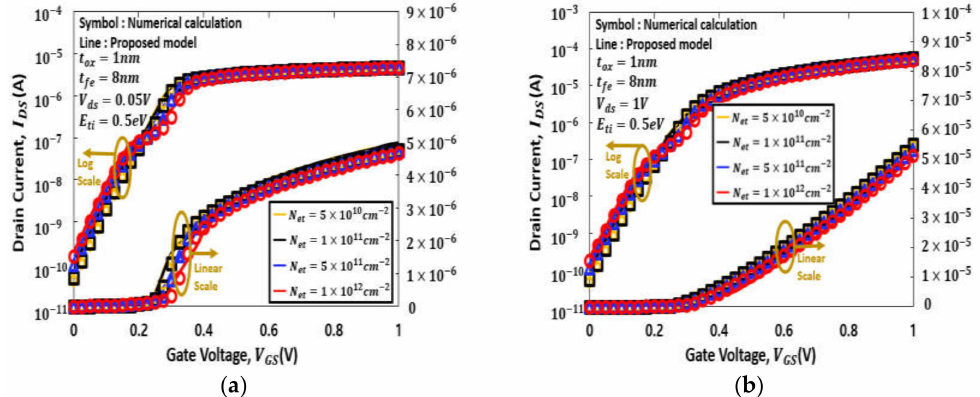
Figure 7. Result of drain current versus gate-to-source voltage when interface trap density per unit surface varies with N et = 5 × 10 10 , 1 × 10 11 , 5 × 10 11 , 1 × 10 12 ; ( a ) low drain bias; ( b ) high drain